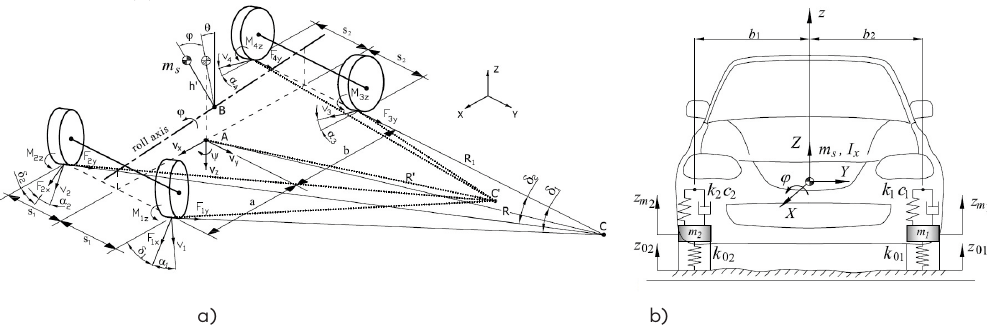
Figure 3. Schemes for vehicle simulation: a) horizontal and roll dynamics (Žuraulis et al., 2015); b) vertical